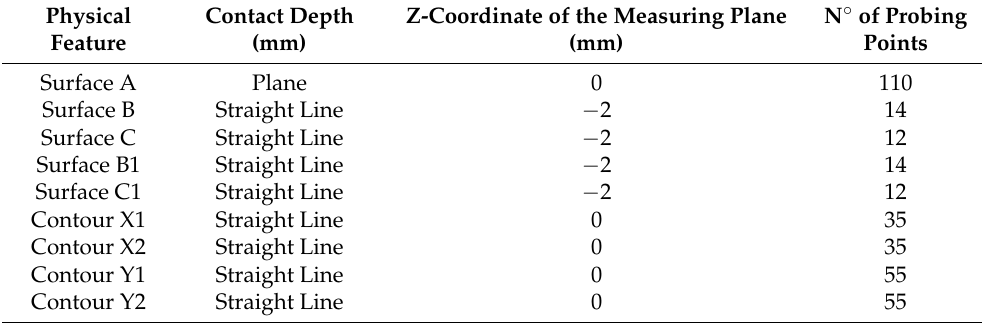
Table 2. Definition of the part probing